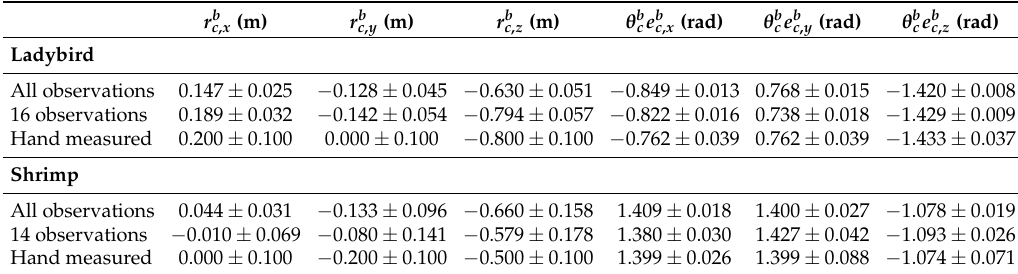
Table 3. t b c estimates and uncertainties (axis-angle rotations).